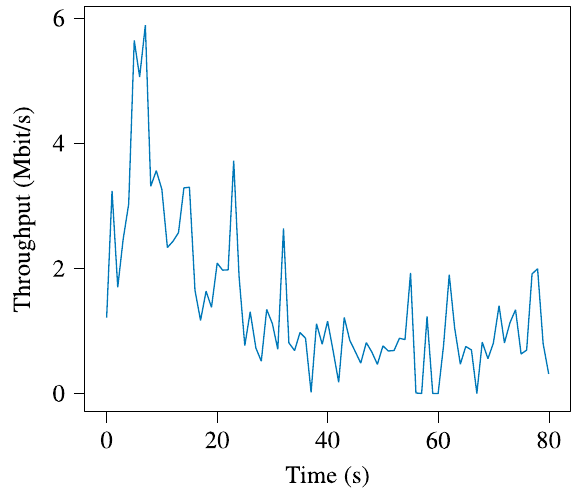
Figure 8. Service channel throughput during H7’s attack of H2, H3, H5, and H10.